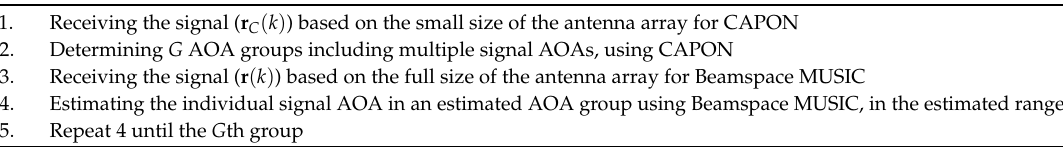
Table 1. Summary of cascade AOA estimation algorithm.